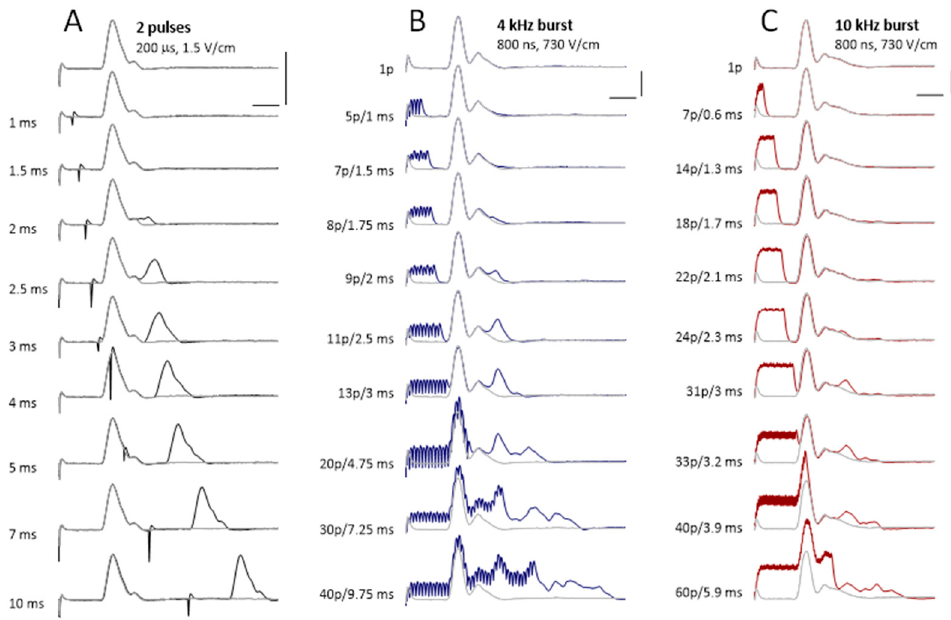
Figure 7. Sample traces of the compound action potentials evoked by paired pulses ( A ) and by 800-ns, 730-V/cm unipolar pulse bursts at 4 kHz ( B ) and 10 kHz ( C ). The interval between pulses ( A ) or the number of pulses per burst and the respective burst duration ( B , C ) were varied and are shown in the legends next to each trace. For ease of comparison, the top trace (CAP evoked by a single pulse) was copied behind all other traces as a thinner light-gray line. Calibration bars are 0.5 mV and 2 ms for all panels.